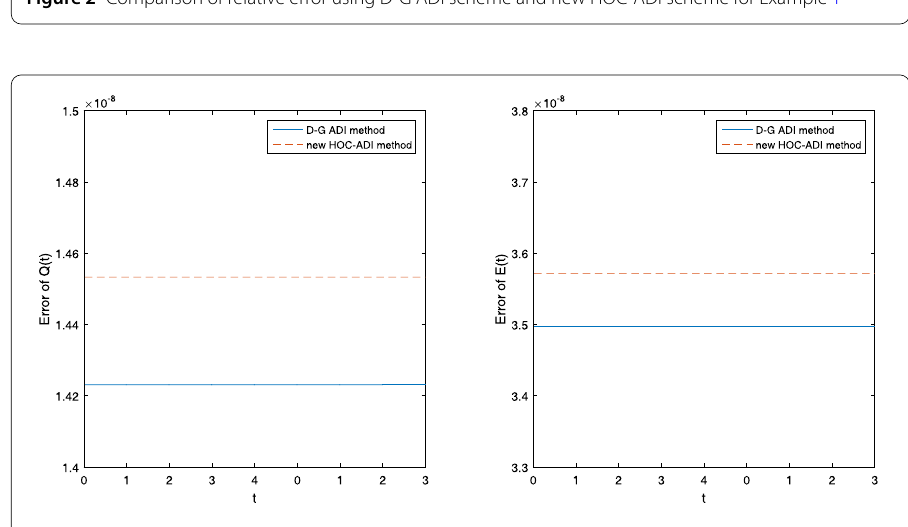
Figure 2 Comparison of relative error using D-G ADI scheme and new HOC-ADI scheme for Example 1